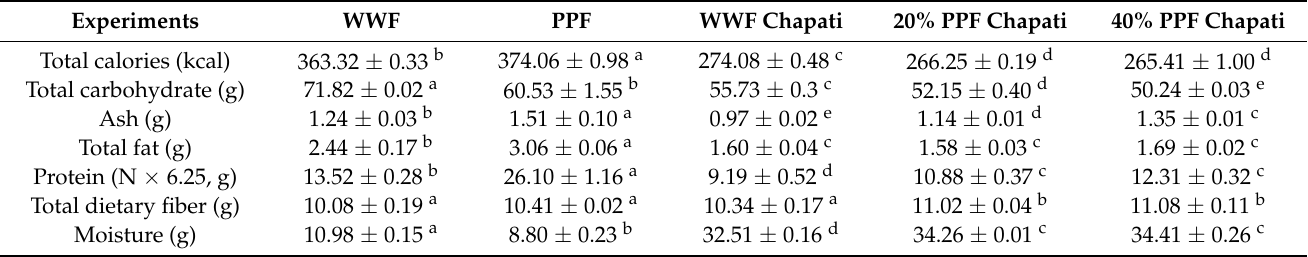
Table 1. Proximate composition (dry matter basis) and moisture (as sampled basis) of pigeon pea flour (PPF), whole wheat flour (WWF) and the chapatis per 100 g